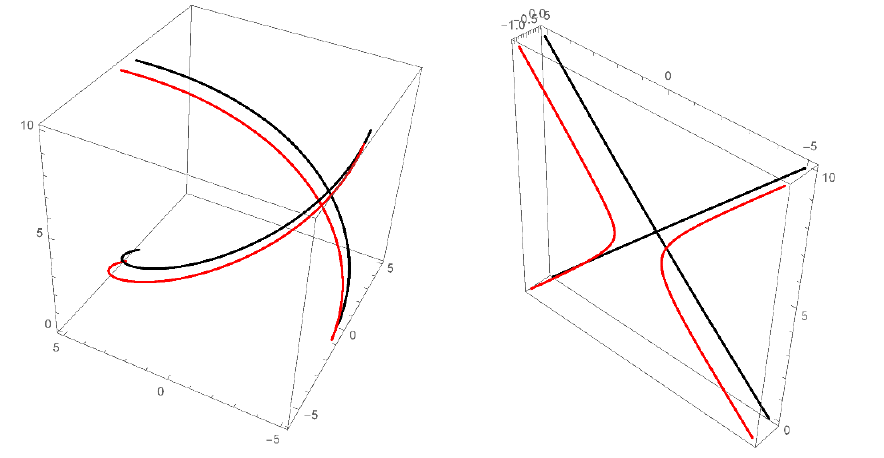
Figure 11 . Hovering solution for ++ vacuum for two